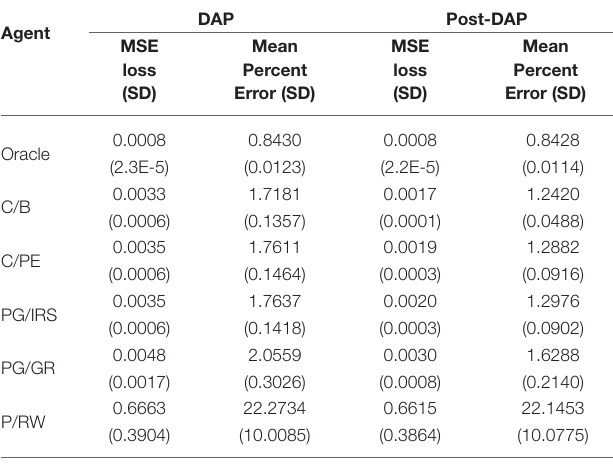
TABLE 2 | Summary statistics on validation loss and error percentage as benchmarking